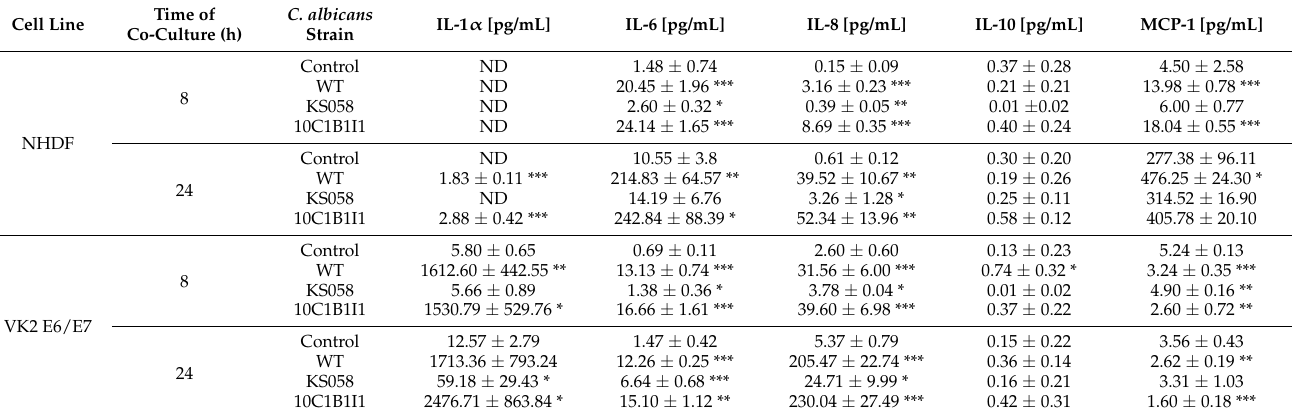
Table 2. Cytokines and chemokines levels (IL-1 α , IL-6, IL-8, IL-10, MCP-1) detected in culture supernatants released in response to infection with C. albicans WT (SC5314), KS058 ( erg11 ∆ / ∆ ) and 10C1B1I1 ( ERG11 K143R / K143R ) strains after 8 or 24 h of co-culture with NHDF or VK2 E6/E7 cell lines ( n = 3; ± SD). Results obtained for WT, KS058 and 10C1B1I1 strains was compared to control conditions of NHDF or VK2 E6/E7 cell lines cultured alone among different time of culture (* p < 0.05; ** p < 0.01; *** p <